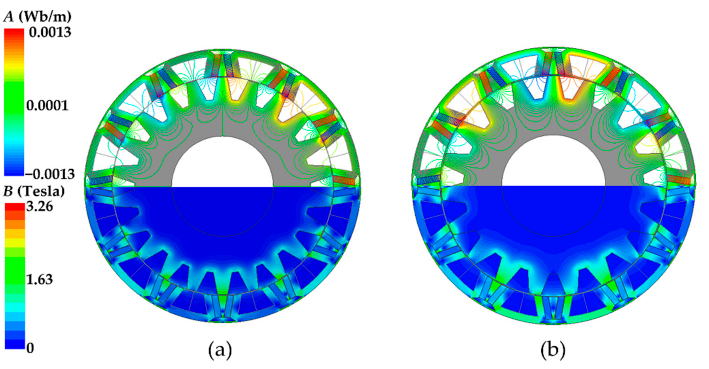
Figure 7 . PM flux-line distributions: ( a ) initial V-shaped structure; ( b ) optimal V-shaped structure .